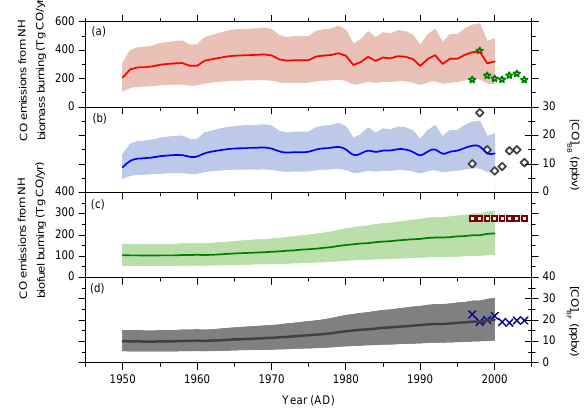
Fig. 5. (a) and (c) : Estimated CO emissions from Northern Hemi- sphere biomass and biofuel burning (TgCOyr − 1 ) based on model simulation (Ito and Penner, 2005). Also shown are 1997–2004 Northern Hemisphere CO emission inventory of biomass burning (van der Werf et al., 2006) (green stars) and biofuel burning (Petron et al., 2004) (red squares), used in MOZART-4 simulation (Park, 2010). (b) and (d) : Calculated CO contribution (ppbv) from biomass ([CO] BB ) and biofuel ([CO] BF ) burning by scaling (see text), which is used in the isotope mass balance model. Also shown are CO con- tributions from biomass burning (grey diamonds) and biofuel burn- ing (blue crosses) at high northern latitudes in MOZART-4 simu- lation (Park, 2010). Shaded areas show the ± 50% uncertainty for estimating both biomass burning and biofuel burning